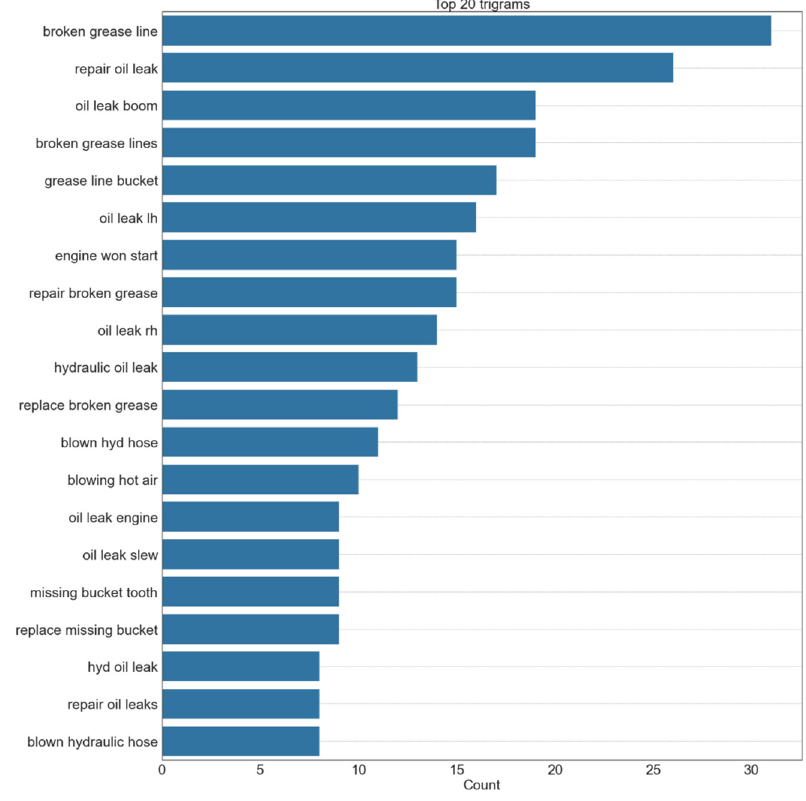
Figure 6. Top 20 trigrams in maintenance records.